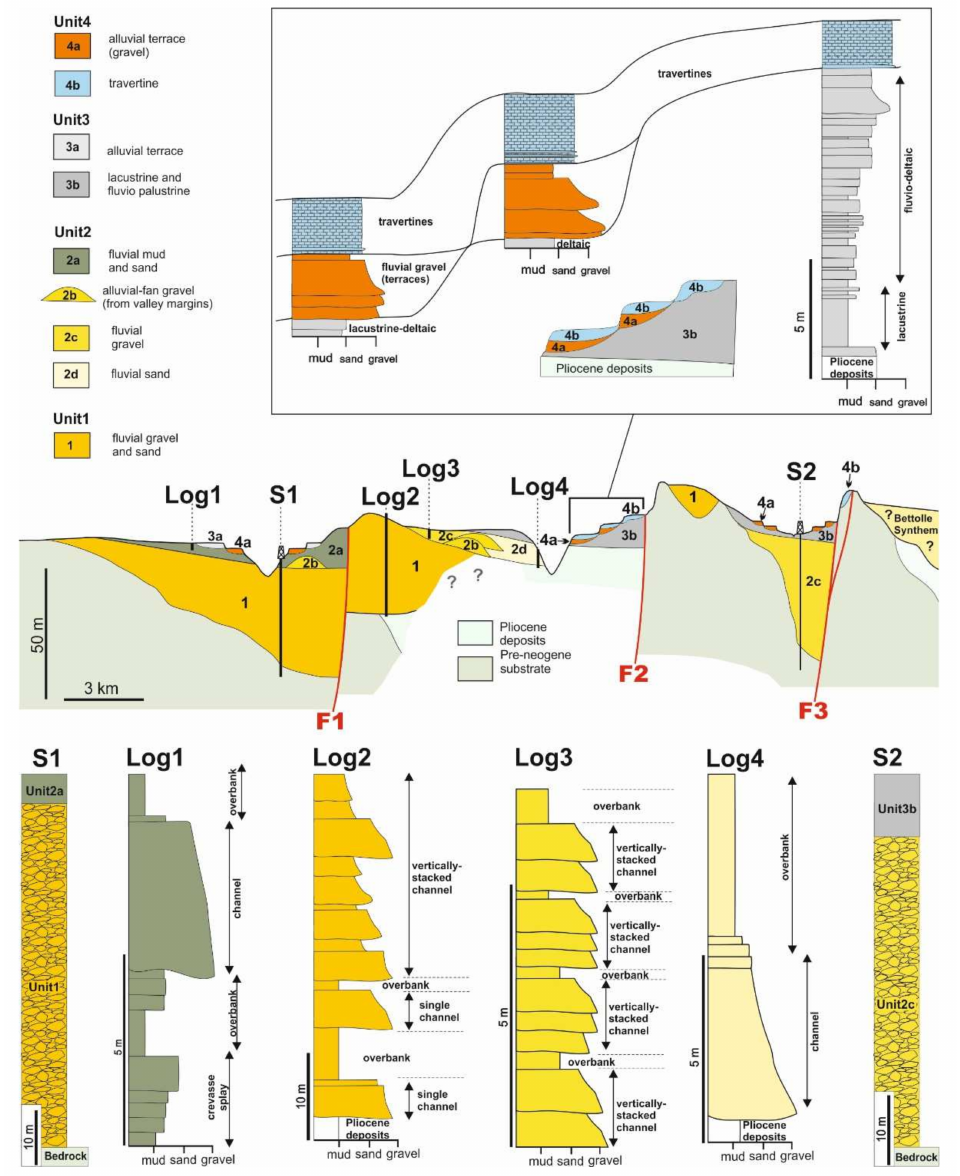
Figure 10. Simplified sedimentological logs and core data from the study deposits. Their location in the idealized longitudinal cross section shown in Figure 9 is